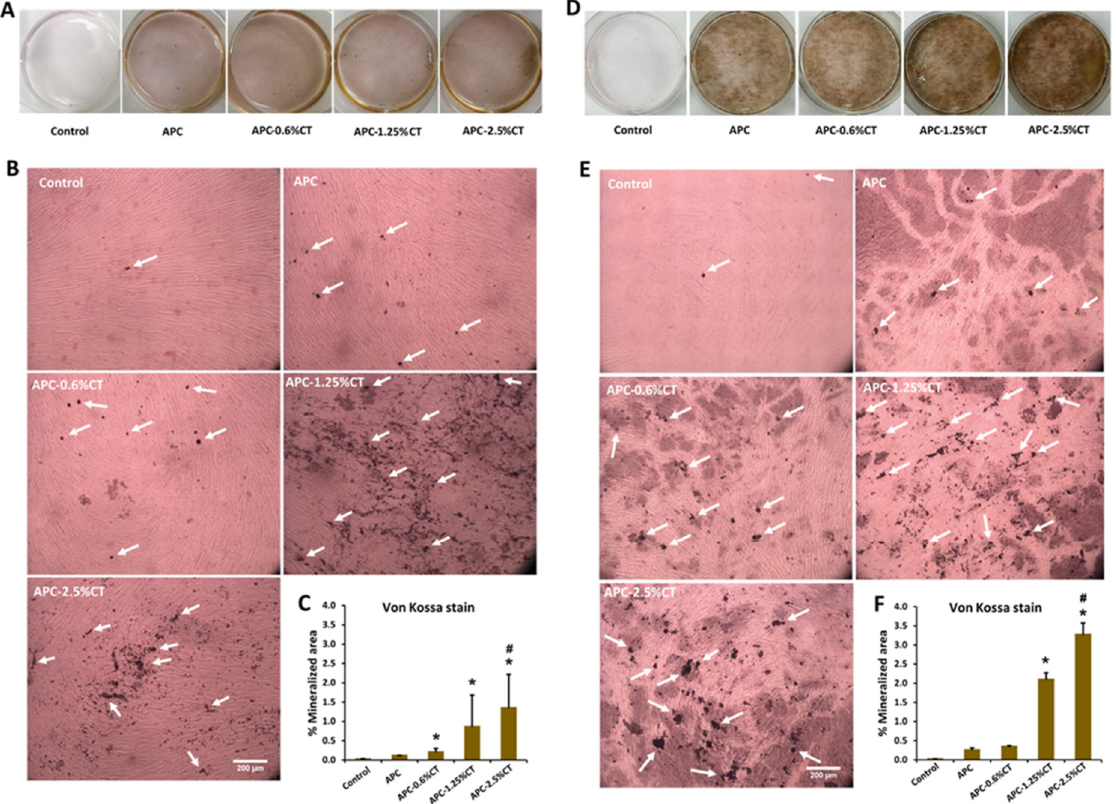
Figure 6. Representative images of mineralized tissue formation after ( A , B ) 14 and ( D , E ) 21 days of SHED exposure to APC and APC-CT as evaluated by Von Kossa stain. White arrow indicates mineralized matrix. Magnification is 100 × . Scale bar = 200 µ m. ( C , F ) Quantitation of mineral deposition as measured by ImageJ software. The data are presented as mean ± SD after 14 and 21 days. * p < 0.05 vs. control and # p < 0.05 vs. APC ( n = 3).